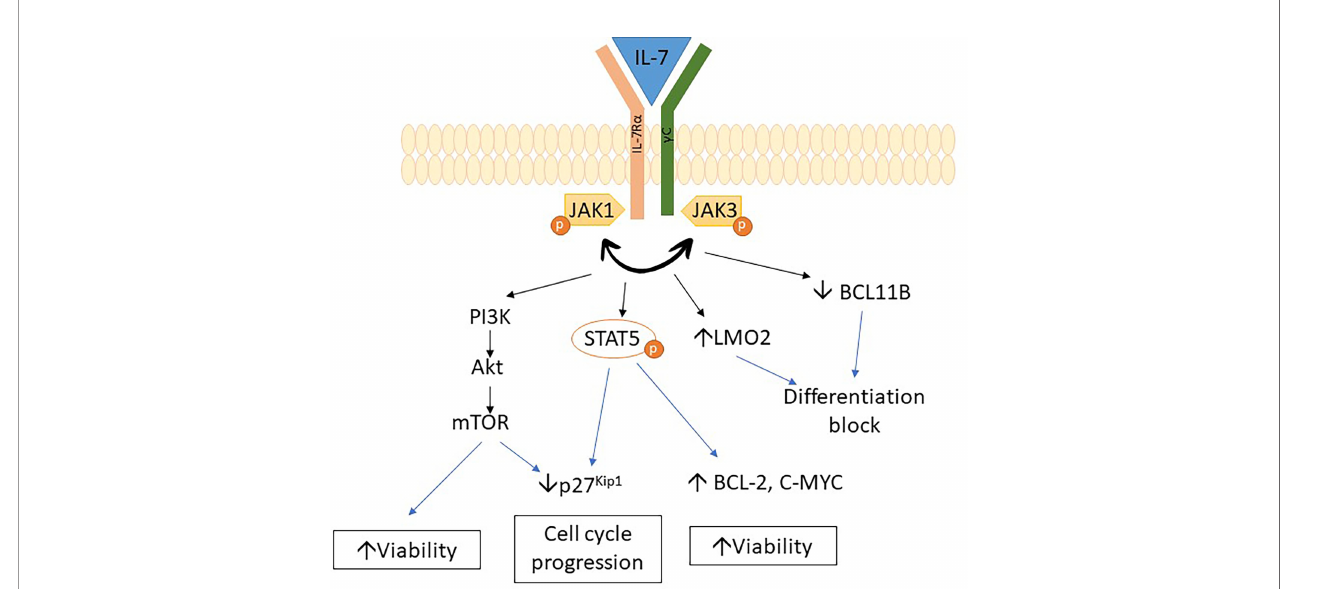
FIGURE 2 | Schematic diagram representing the mechanism of leukemogenesis of IL7R mutations.